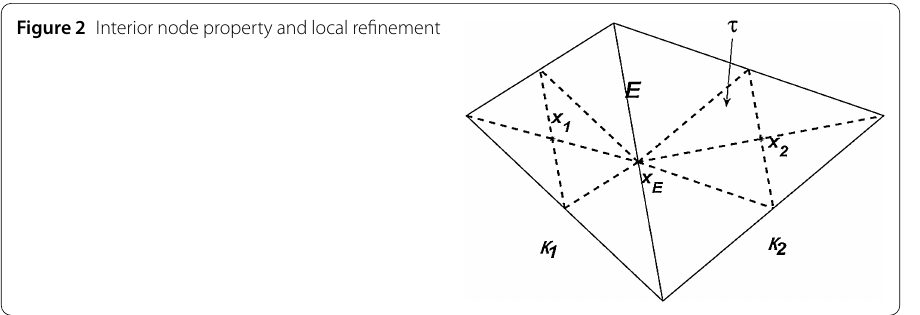
Figure 2 Interior node property and local